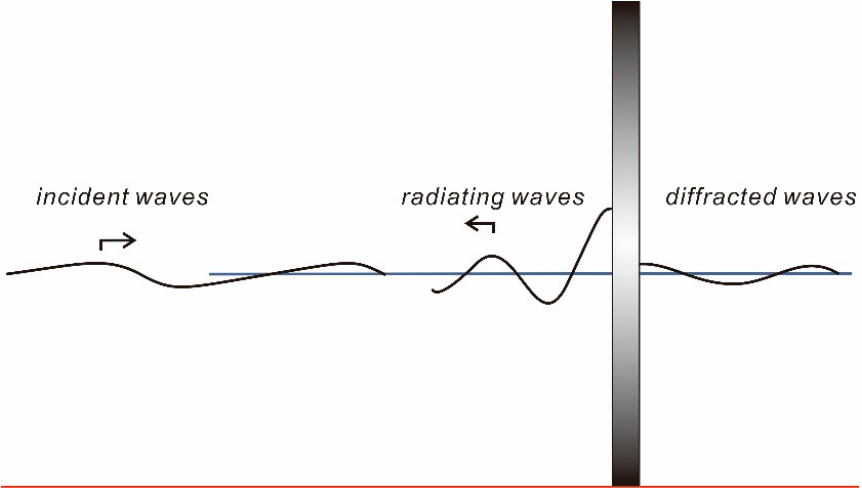
Figure 5. Wave field near the mono-pile for offshore wind turbines.